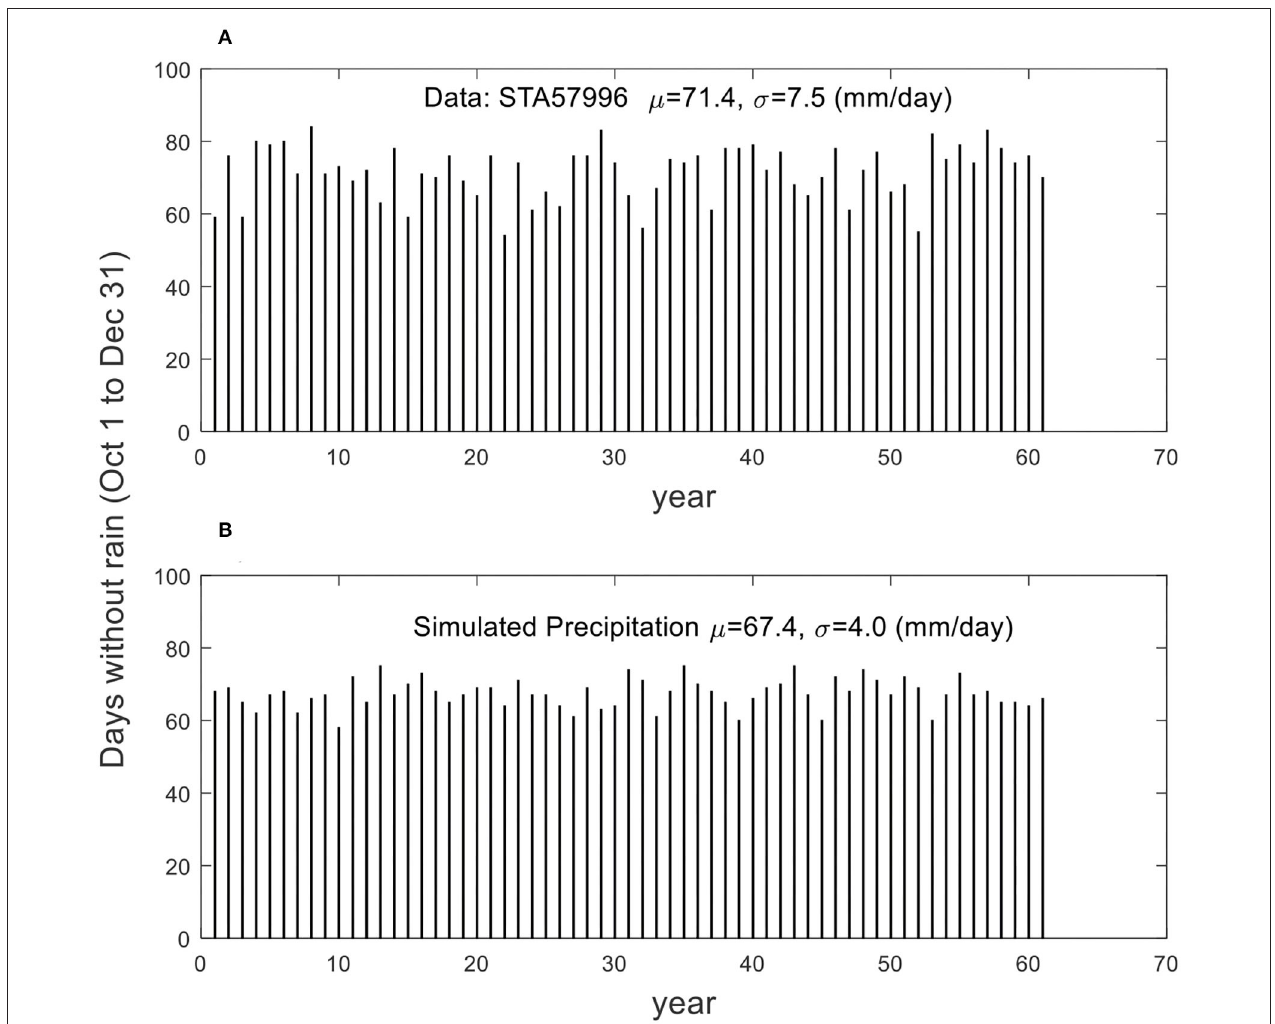
FIGURE 9 | The days without rain of the dry seasons over 61 years (A) from STA57996 records, (B) from simulated data using monthly gamma distribution shown in Figure 8D